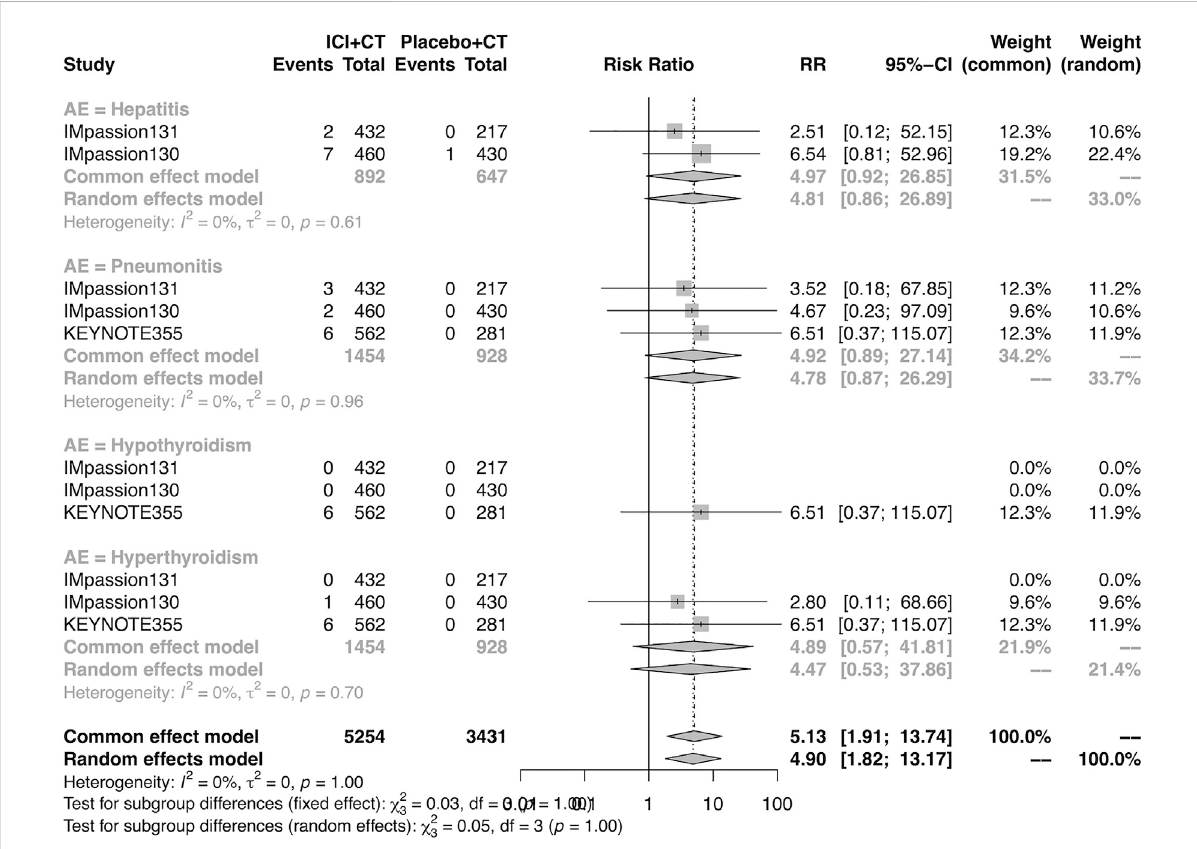
FIGURE 10 Pooledgrade ≥ 3AEsinadjuvanttherapyclinicaltrials:severecutaneousreactions.AEs,adverseevents;RR,relativerisk;95%CI,95%con fi dence interval; ICIs, immune checkpoint inhibitors; CT,